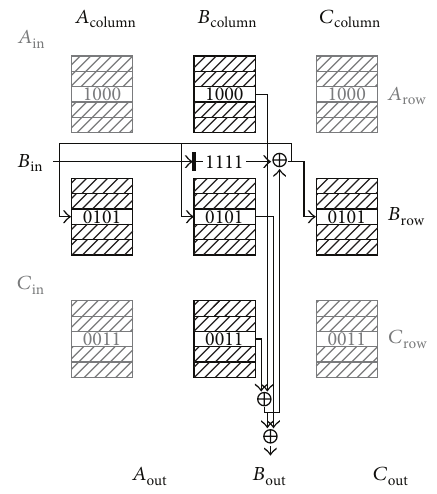
Figure 2: In this XOR memory example 1111 is being written on port 𝐵 . This results in 1000⊕0011⊕1111 = 0100 being written on all the RAM blocks on 𝐵 row . The next time this address is read the result will be 1000 ⊕ 0100 ⊕ 0011 = 1111